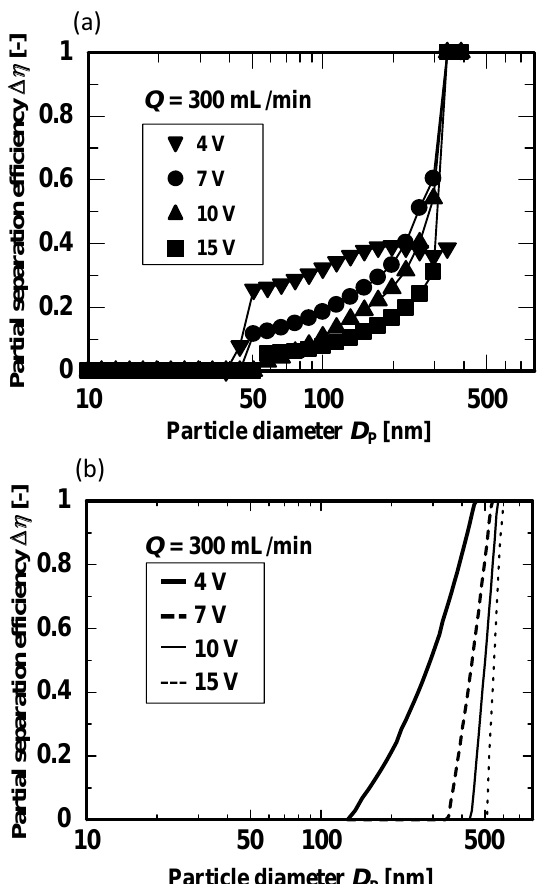
Fig. 4 Effect of applied voltage on partial separation efficiency curves at Q = 300 mL/min by: (a) ex- periment; (b) numerical